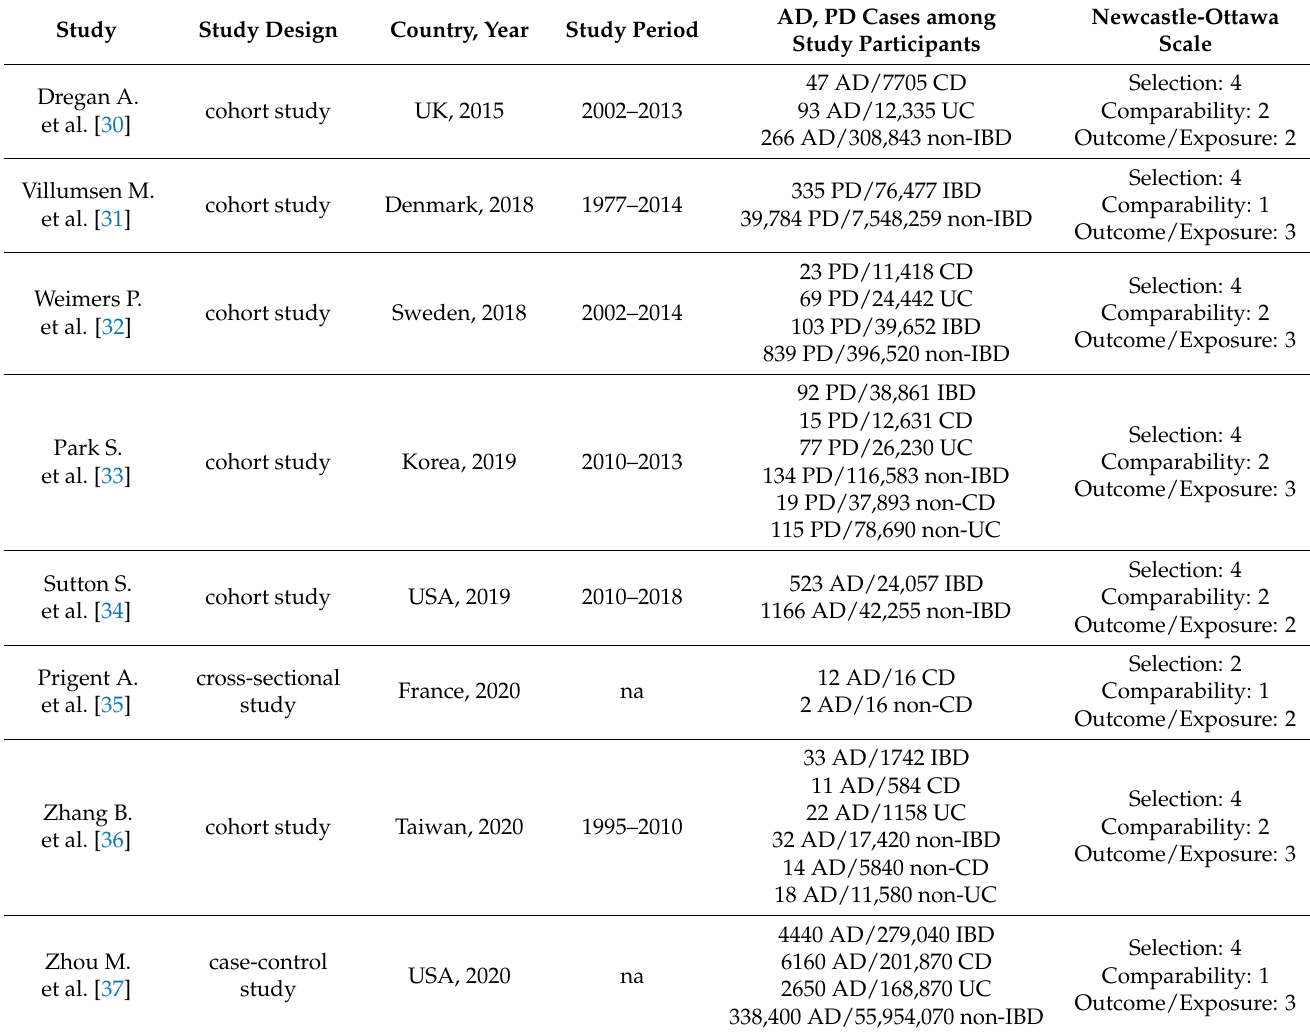
Table 1. Main characteristics of eight studies included in this